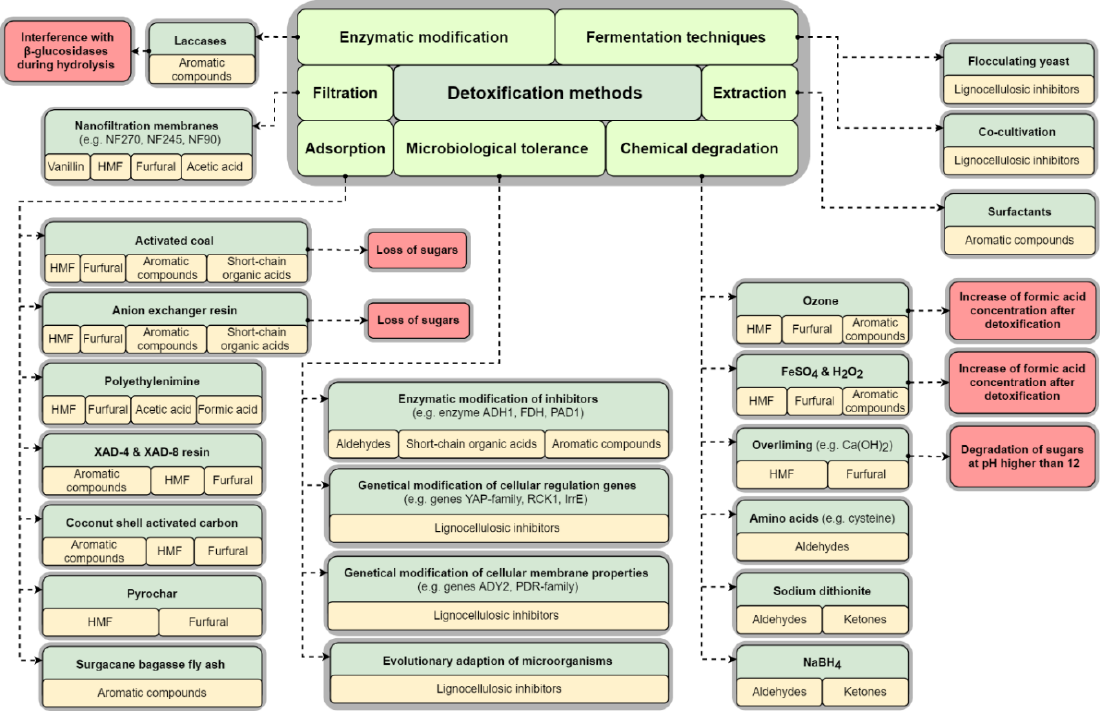
Figure 3. Different detoxification methods for lignocellulosic hydrolysates. Figure 3. Di ff erent detoxification methods for lignocellulosic